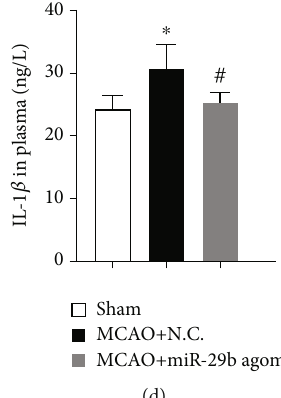
Figure 4: miR-29b downregulated C1QTNF6 expression in leukocytes of MCAO rats. (a) C1QTNF6 mRNA levels in leukocytes and the brain. N = 6 . (b) Protein expression of C1QTNF6 and interleukin- (IL-) 1 β in leukocytes assessed by Western blot. N = 6 . (c) Protein levels of C1QTNF6 and IL-1 β in the brain measured by Western blot. N = 6 . (d) IL-1 β expression in plasma measured at 24 h after MCAO injury. N = 12 . ∗ P < 0 : 05 and ∗∗∗ P < 0 : 001 vs. sham group. # P < 0 : 05 and ### P < 0 : 001 vs. MCAO+NC group.